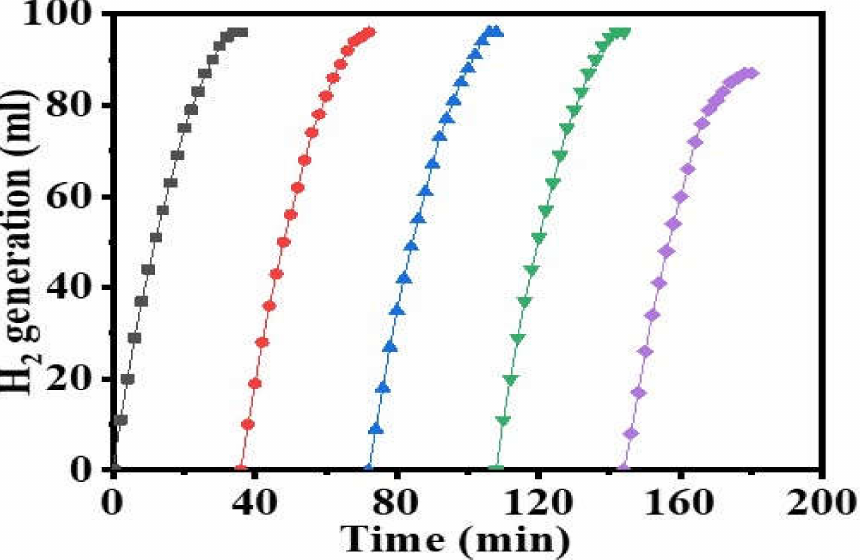
Figure 10. Reusability test of Ni 0.7 Cu 0.3 @PVDF-HFP NF membranes. (The amount of cata- lyst = 100 mg, (SBH) = 1 mmol, and T = 298